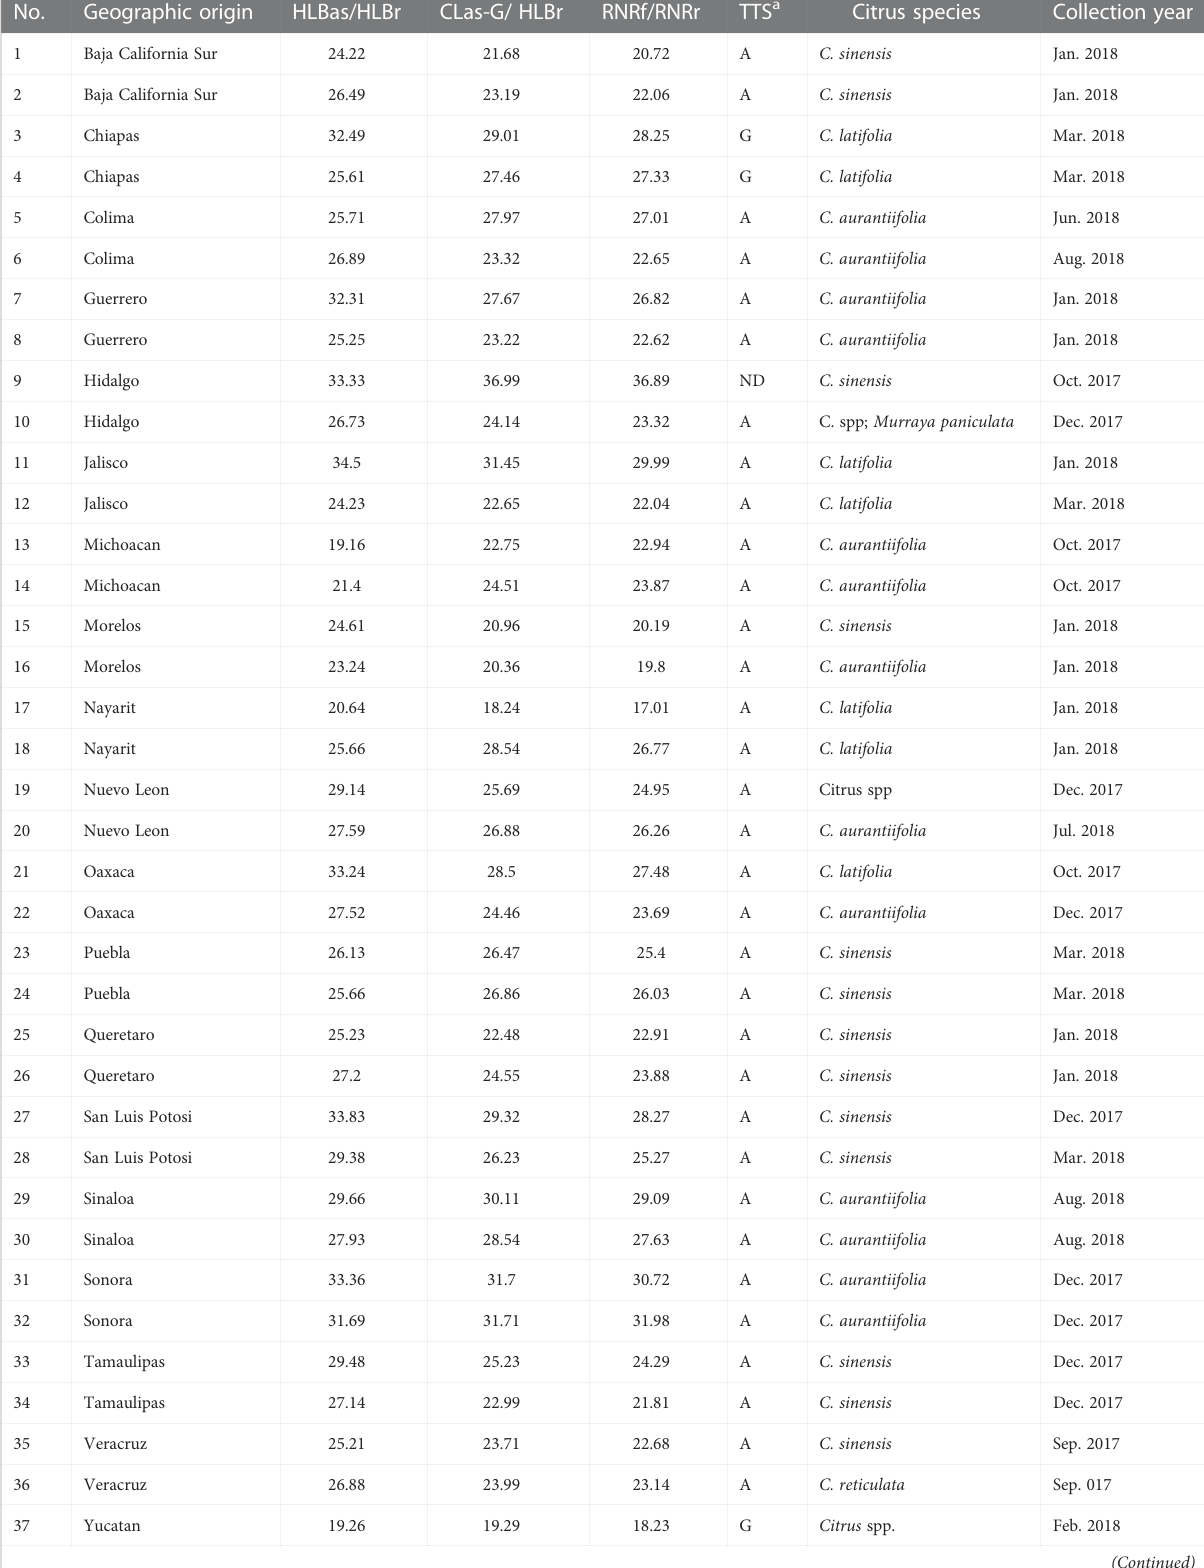
TABLE 1 General information of Asian citrus psyllid (ACP, Diaphorina citr i) samples collected from 20 states in Mexico and the result of PCR detections and typing with terL typing system (TTS).